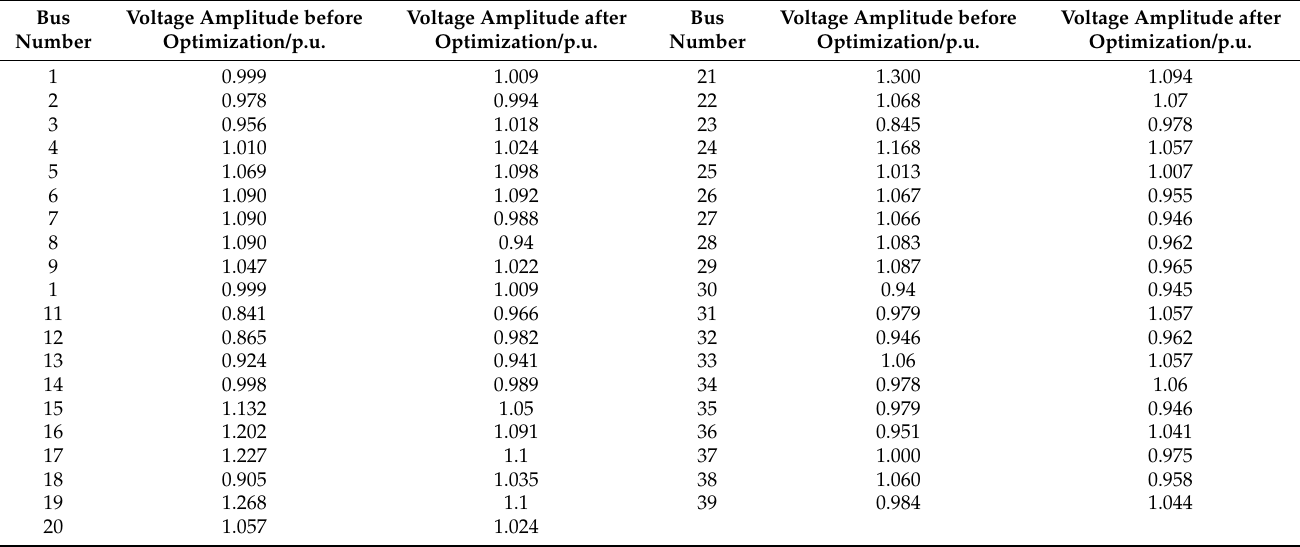
Bus Voltage Amplitude before Number Optimization/p.u.